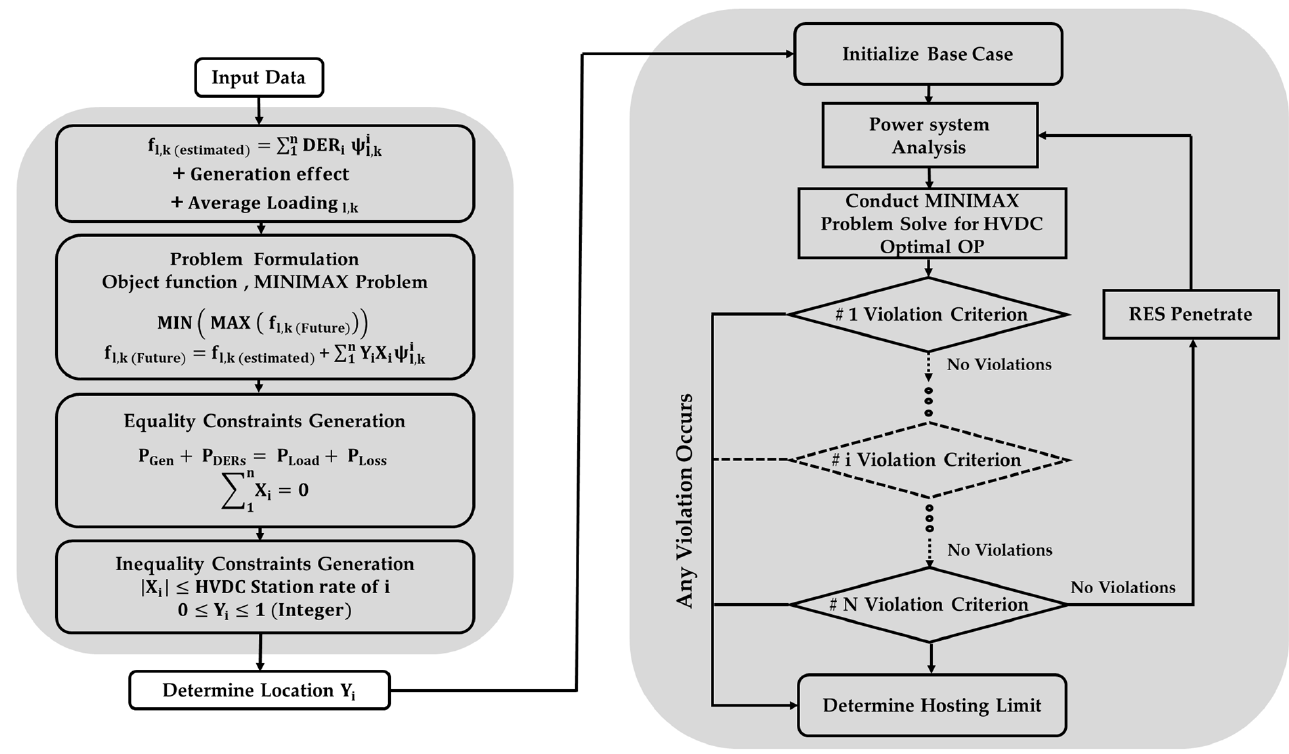
Figure 3. Proposed methodology conduct procedure.